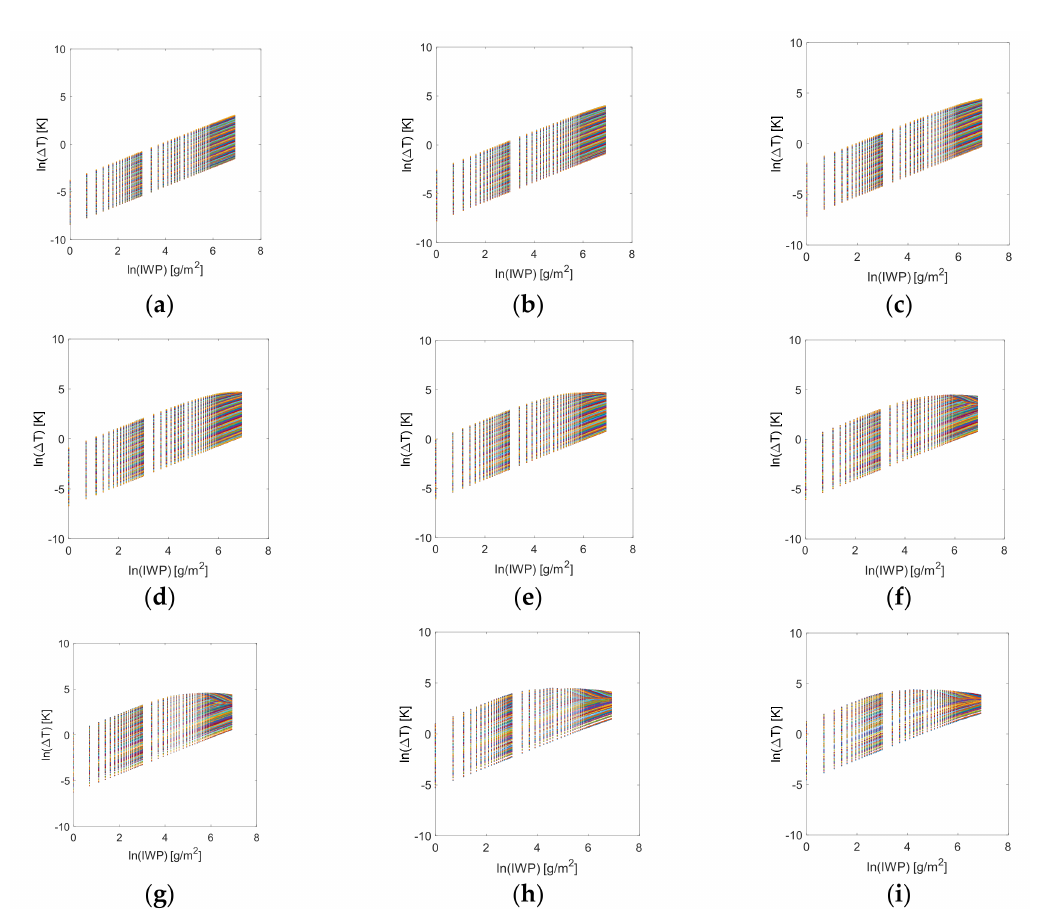
Figure 6. Logarithmic plot of brightness temperature di ff erence ( ∆ T ) with ice water path ( IWP ) at di ff erent particle sizes and cloud heights. ( a ) 118.75 ± 5.0 GHz (O2). ( b ) 157.05 ± 2.6 GHz (Window). ( c ) 183.31 ± 7.0 GHz (H2O). ( d ) 243.20 ± 2.5 GHz (Window). ( e ) 325.15 ± 9.5 GHz (H2O). ( f ) 424.70 ± 4.0 GHz (O2). ( g ) 448.0 ± 7.2 GHz (H2O). ( h ) 664.0 ± 4.2 GHz (Window). ( i ) 874.4 ± 6.0 GHz